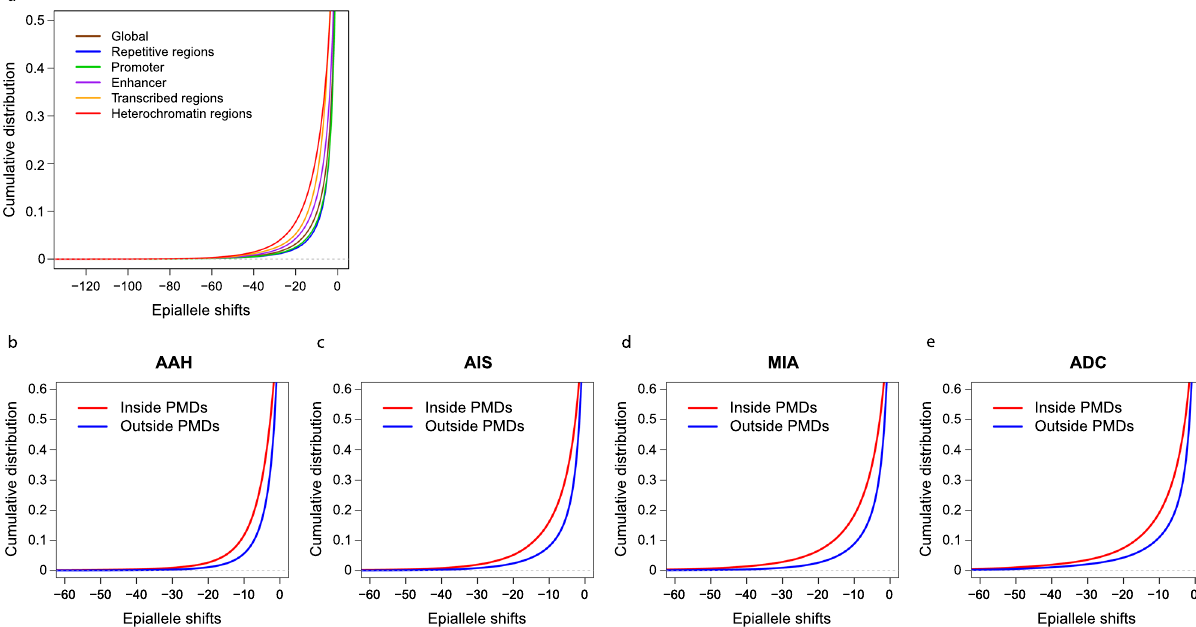
Fig. 4 Comparison of methylation ITH by epiallele shifts in different genomic regulatory regions and PMDs. a Cumulative distribution curves of epiallele shifts (from IPN specimens versus its matched normal lung tissues) of consecutive loci located in promoters, enhancers, transcribed regions, and repressed regions (heterochromatin) are shown, with 1st percentile of entropy as − 34.07 for all genomic regions, − 30.87 for promoters, − 38.12 for enhancers, − 42.44 for transcribed regions, − 45.48 for repressed regions, and − 29.51 for repetitive regions by quantile regression. Cumulative distribution of epiallele shifts (from IPN specimens versus its matched normal lung tissues) of consecutive loci located inside PMDs (red) versus outside PMDs (blue), with 1st percentile of entropy as − 29.10 inside PMDs and − 20.73 outside PMDs in AAH ( b ), − 37.60 inside PMDs and − 28.05 outside PMDs in AIS ( c ), − 44.74 inside PMDs and − 29.25 outside PMDs in MIA ( d ), − 50.82 inside PMDs and − 41.25 outside PMDs in ADC ( e ) by quantile regression. The boundary of PMDs is derived from WGBS pro fi ling of normal lung. Source data is provided as a source data fi